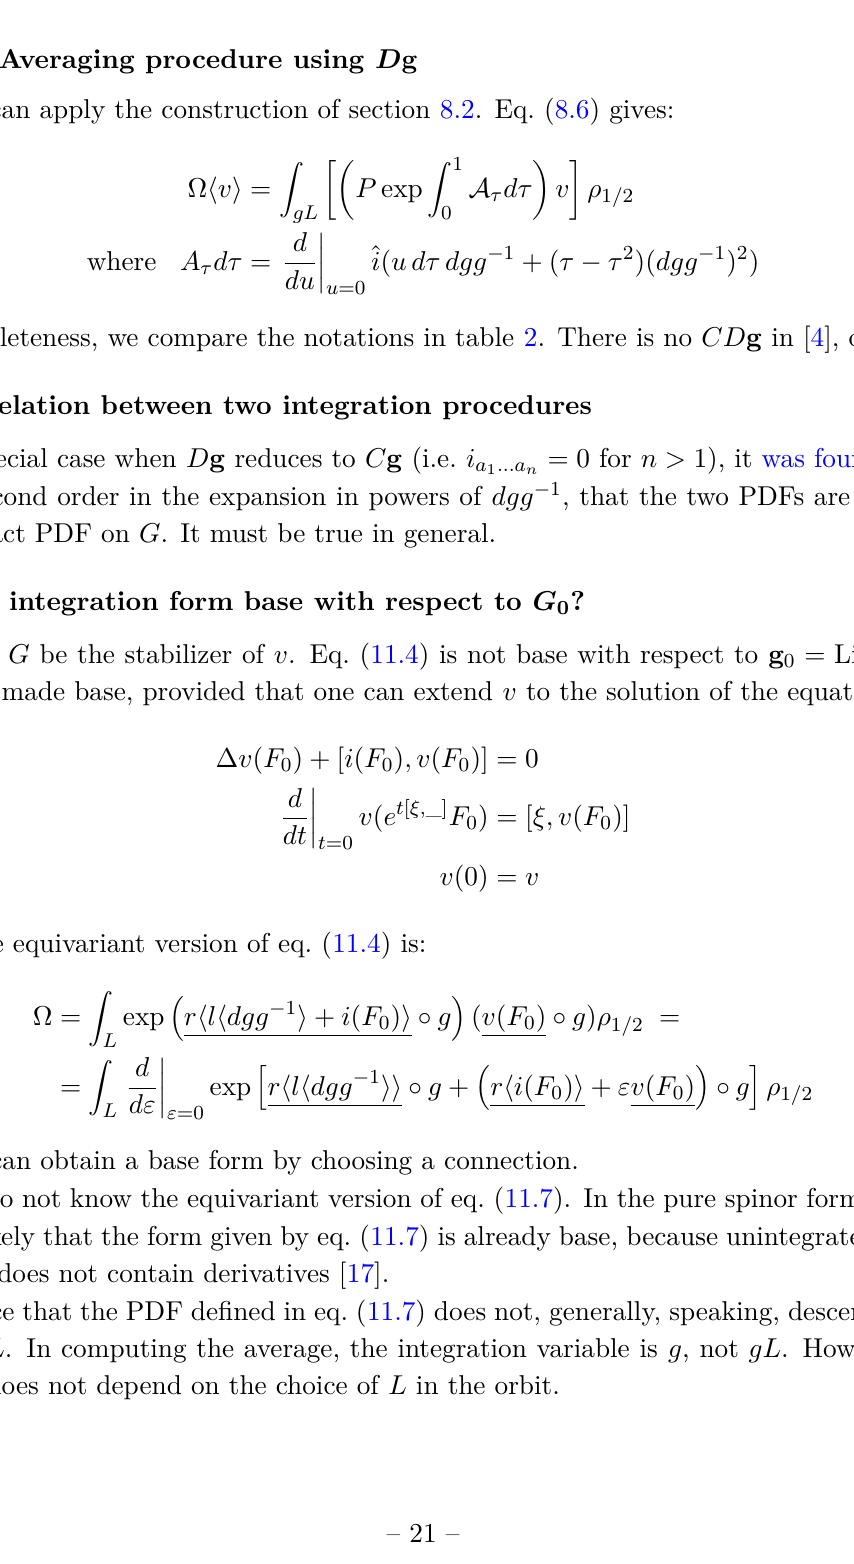
Table 2 . Summary of